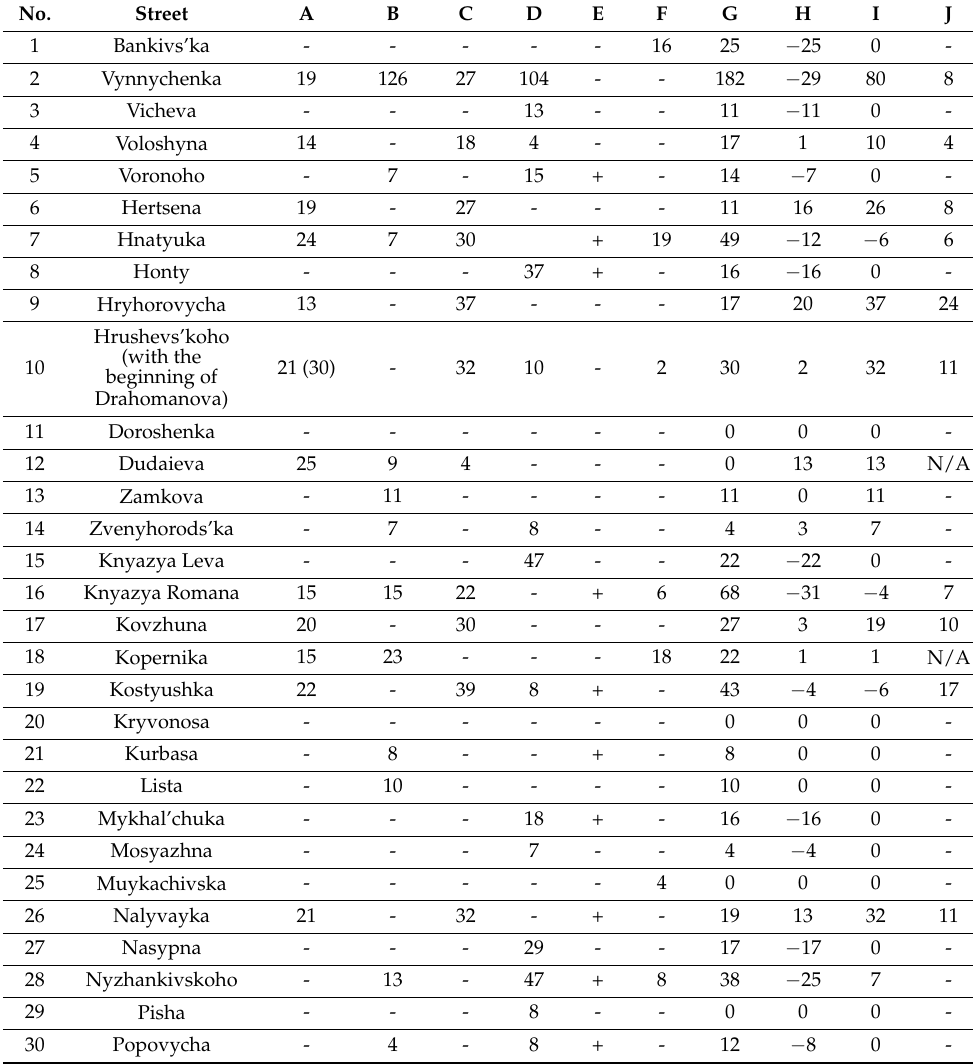
Table 3. Results of the on-street parking field survey in the city center, 2021.